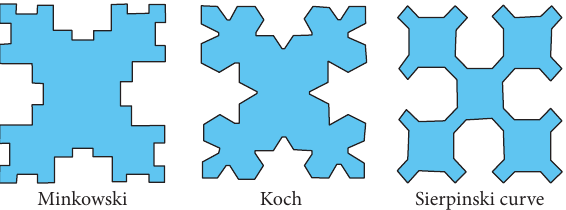
Figure 21: Different fractal boundary structures proposed and simulated in